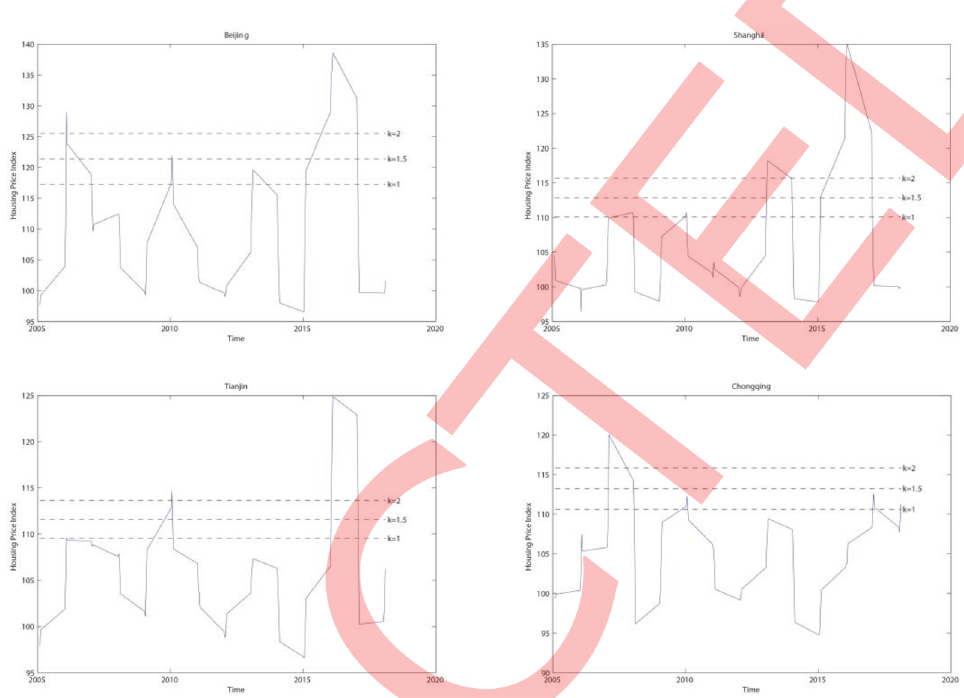
Fig 1. Housing price indexes for selected cities. The solid lines are the growth rates of housing prices. The dashed lines are crisis-identification thresholds with k = 1, 1.5 and 2.